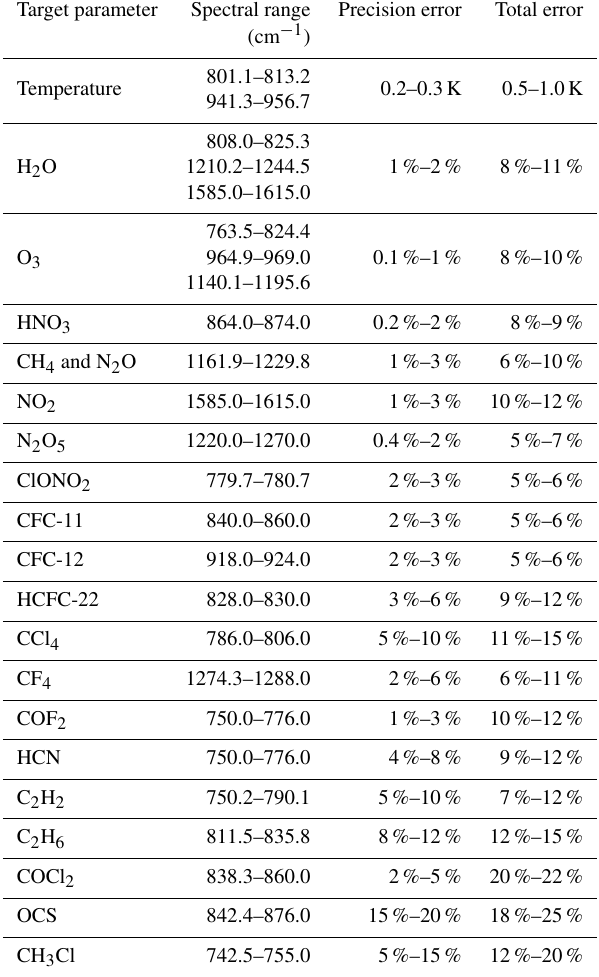
Table 2. Overview of MIPAS-B spectral windows used for the anal- ysis of atmospheric target parameters, together with typical preci- sion errors and total